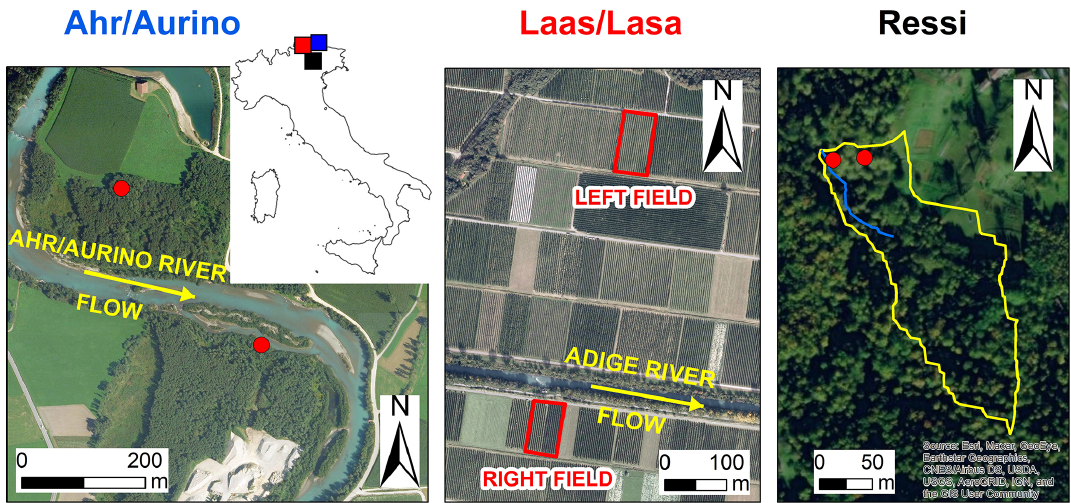
Figure 1. Aerial photos of the study sites and location in northern Italy (blue: Ahr/Aurino; red: Laas/Lasa; black: Ressi). Red dots in Ahr/Aurino and Ressi indicate the approximate position of the sampled trees. In Ressi, the blue and the yellow solid lines mark the stream network and the catchment divide, respectively. Sources of aerial photos: © Autonomous Province of Bolzano-South Tyrol (study sites: Ahr/Aurino and Lasa); Esri, “World Imagery” [basemap], scale not given, “World Imagery”, 14 August 2020, http://www.arcgis.com/home/ item.html?id=10df2279f9684e4a9f6a7f08febac2a9, (last access: 1 September 2020) (study site: Ressi). The maps were made using Esri ArcGIS 10.7.1.